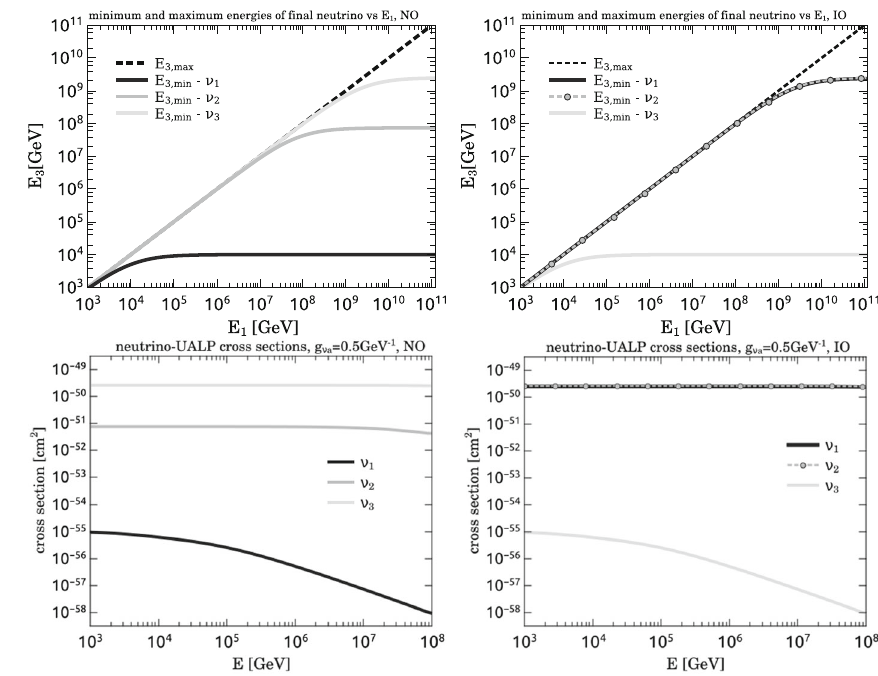
Fig. 3 Total cross sections as a function of the neutrino energy for the three massive